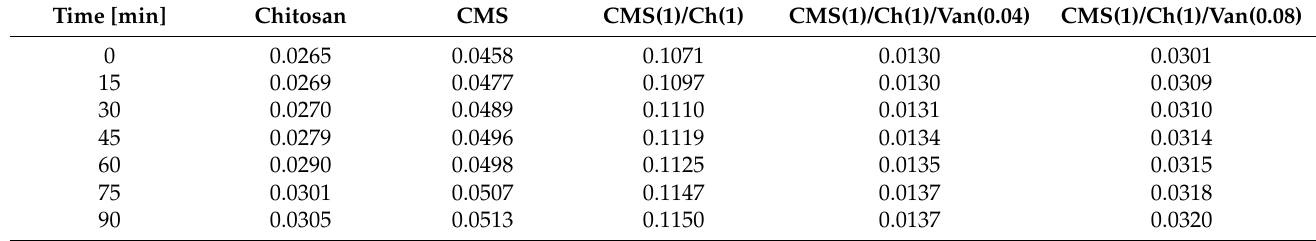
Table 8. Comparison of the weight results of the samples during surface water absorption.